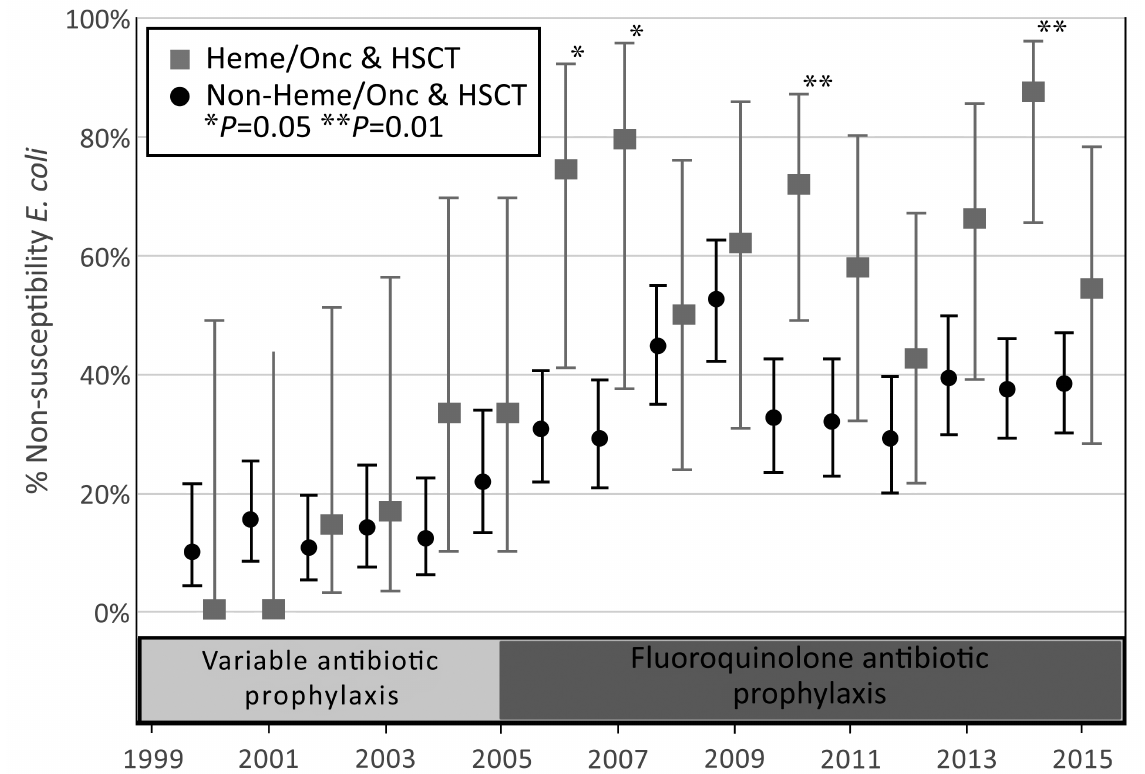
Figure 1. Trend in fluoroquinolone non-susceptibility rates in first E. coli positive blood culture by year of occurrence, 2000-2015. The error bars represent 95% confidence intervals. HSCT, hemato- poietic stem cell transplant. Abbreviations: HSCT, hematopoietic stem cell